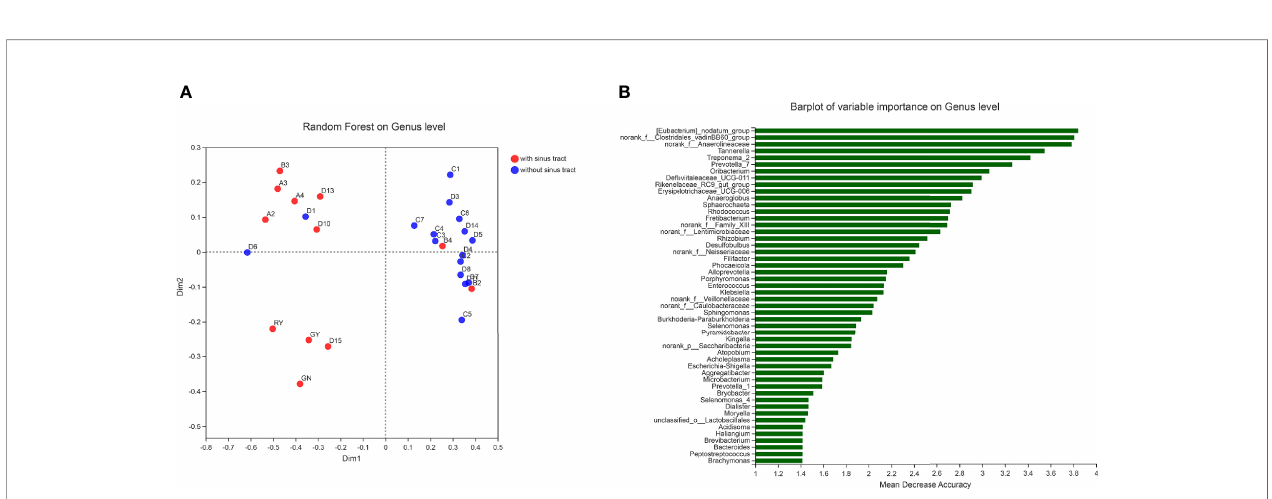
FIGURE 5 | Genera presented signi fi cantly different relative abundances between samples with or without sinus tracts. *P < 0.05; **P < 0.01; ***P < 0.001.